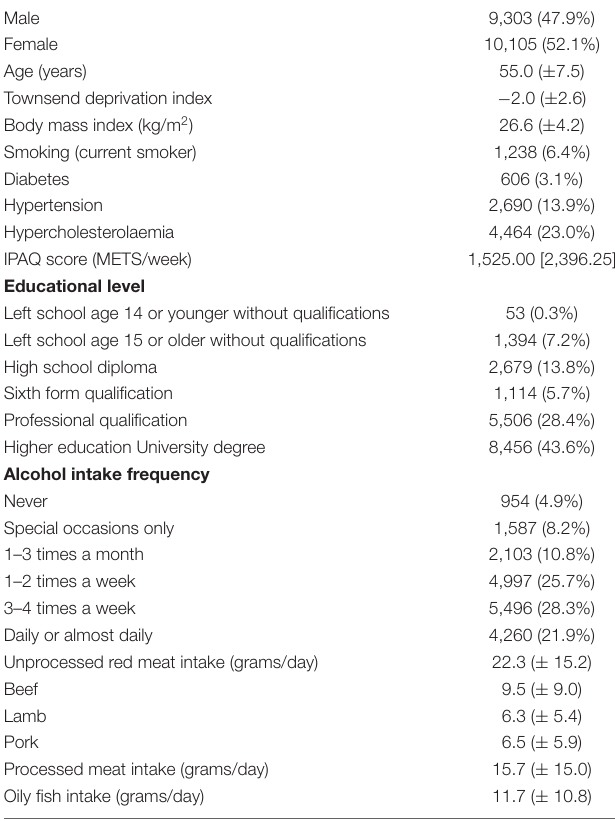
TABLE 1 | Baseline population